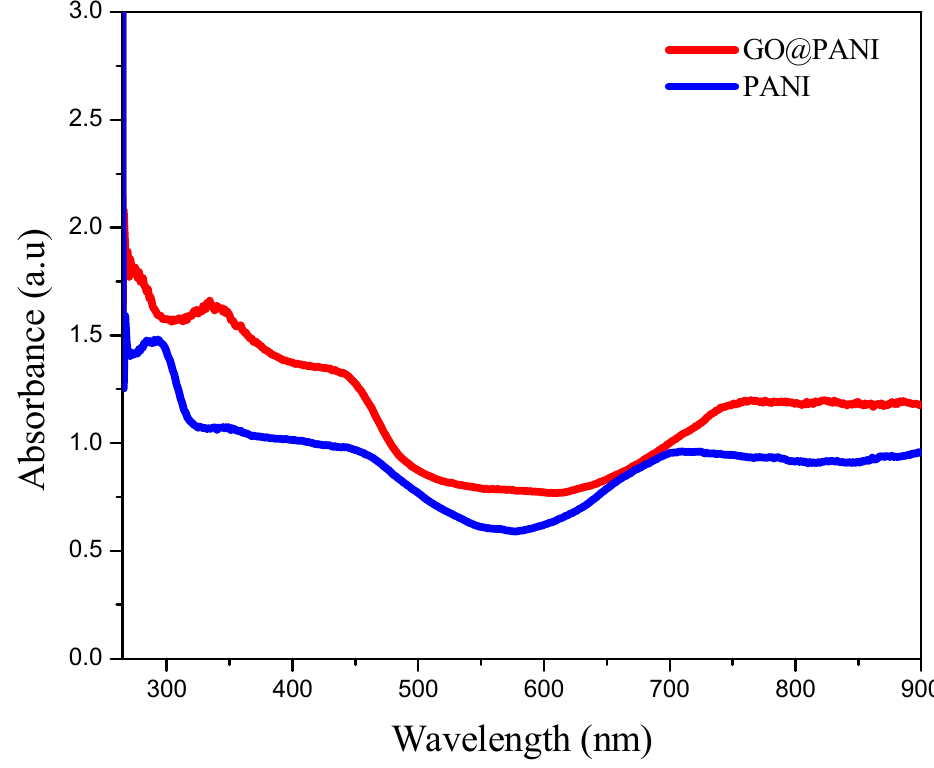
Figure 2. Ultraviolet (UV)-Visible spectra for GO@PANI nanocomposite and PANI.